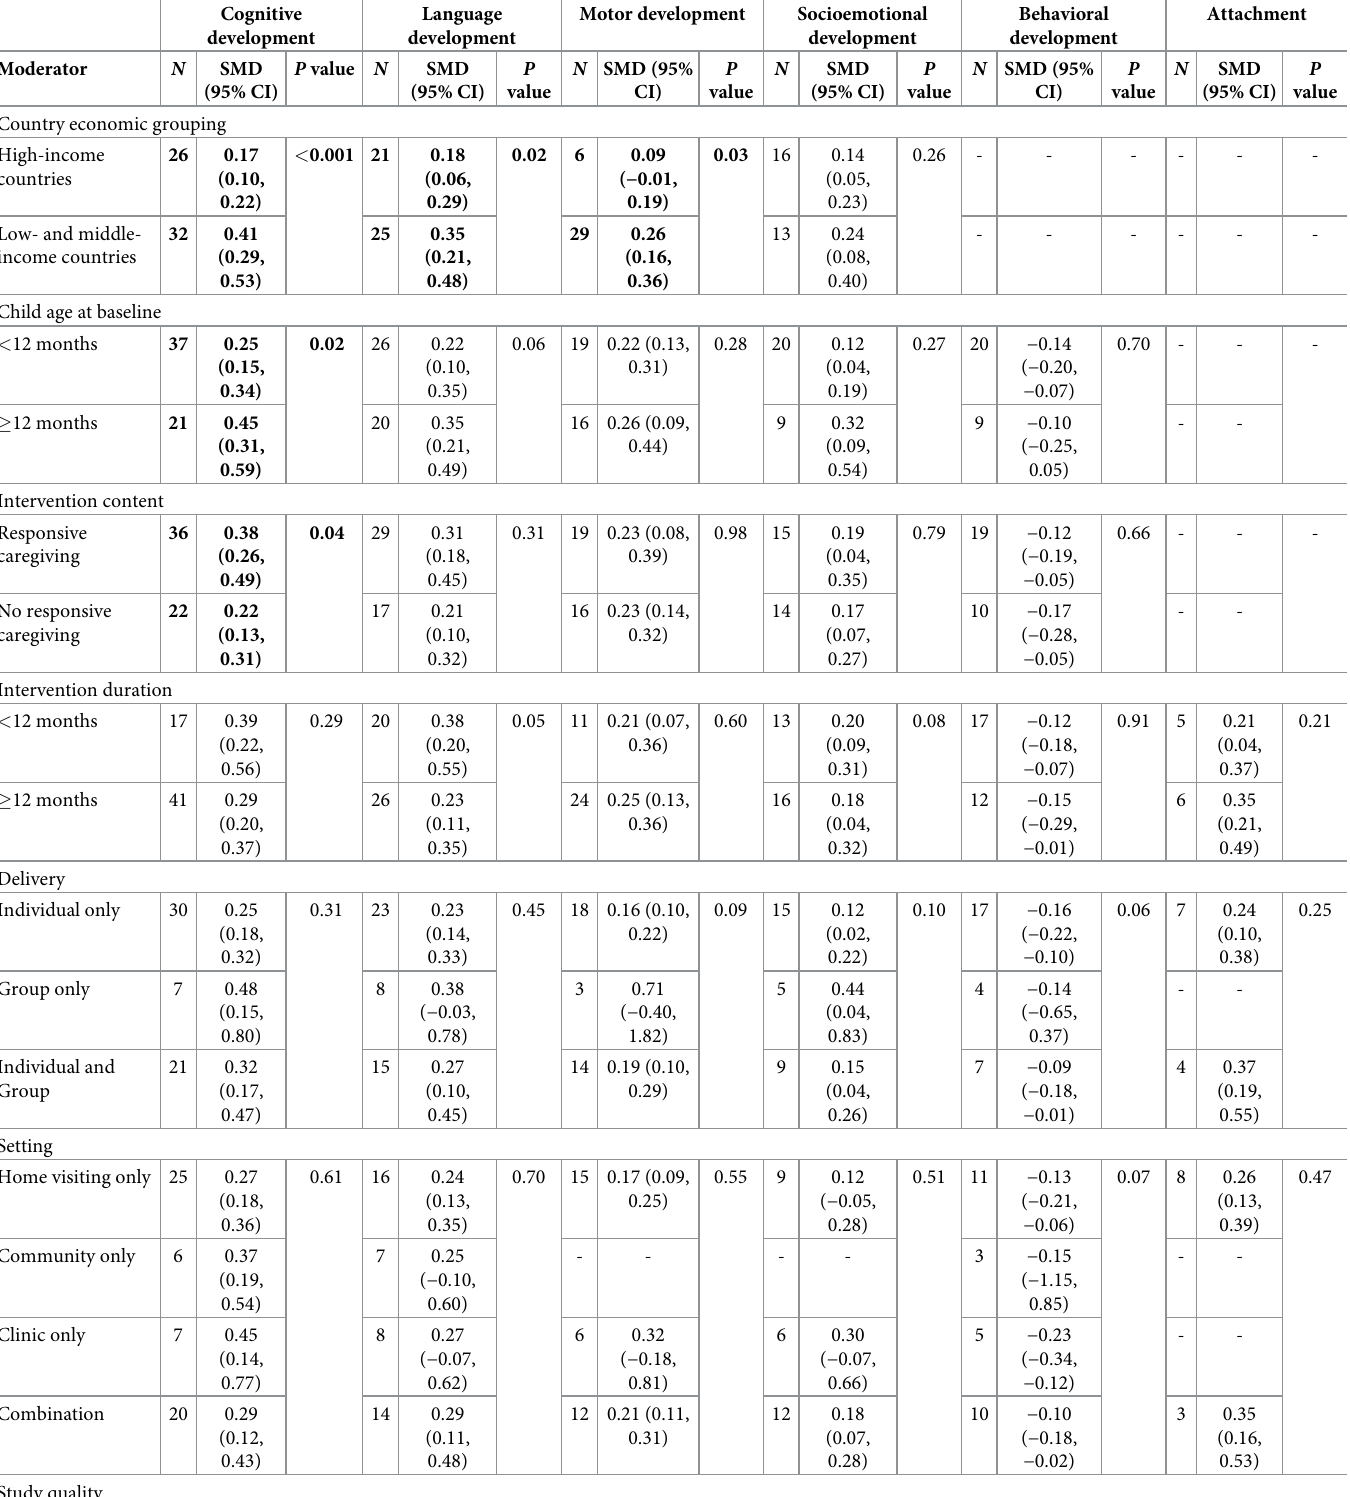
Table 2. Subgroup results for the effect of parenting interventions on early child development outcomes stratified by study